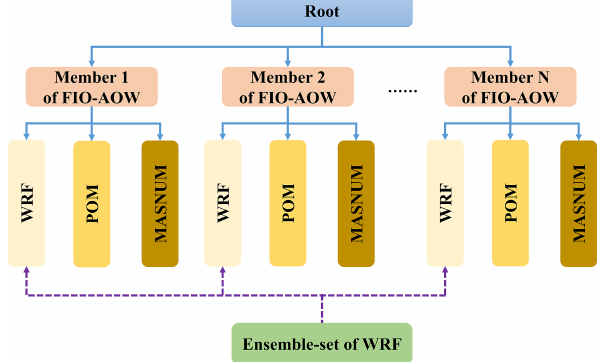
Figure 12. Example of the process layout of the example ensemble DA system FIO-AOW. (a) Each ensemble member of FIO-AOW (yellow series) uses seven MPI processes, where WRF (blue series) uses three MPI processes, POM (green series) uses two MPI pro- cesses, and MASNUM (orange series) uses two MPI processes. (b) Two DA algorithm instances of GSI are adopted for each member (pink series) and ensemble mean (red), respectively, following an- other DA algorithm instance of EnKF in this DA system. (c) Pro- cess layout of the DA system: the process layout of ensemble mem- bers of component models and the process layout of DA algorithms. Each number in the colored boxes in (a) and (c) indicates the pro- cess ID in the corresponding local communicator of a member of the coupled model, a member of a component model or all mem- bers of a component